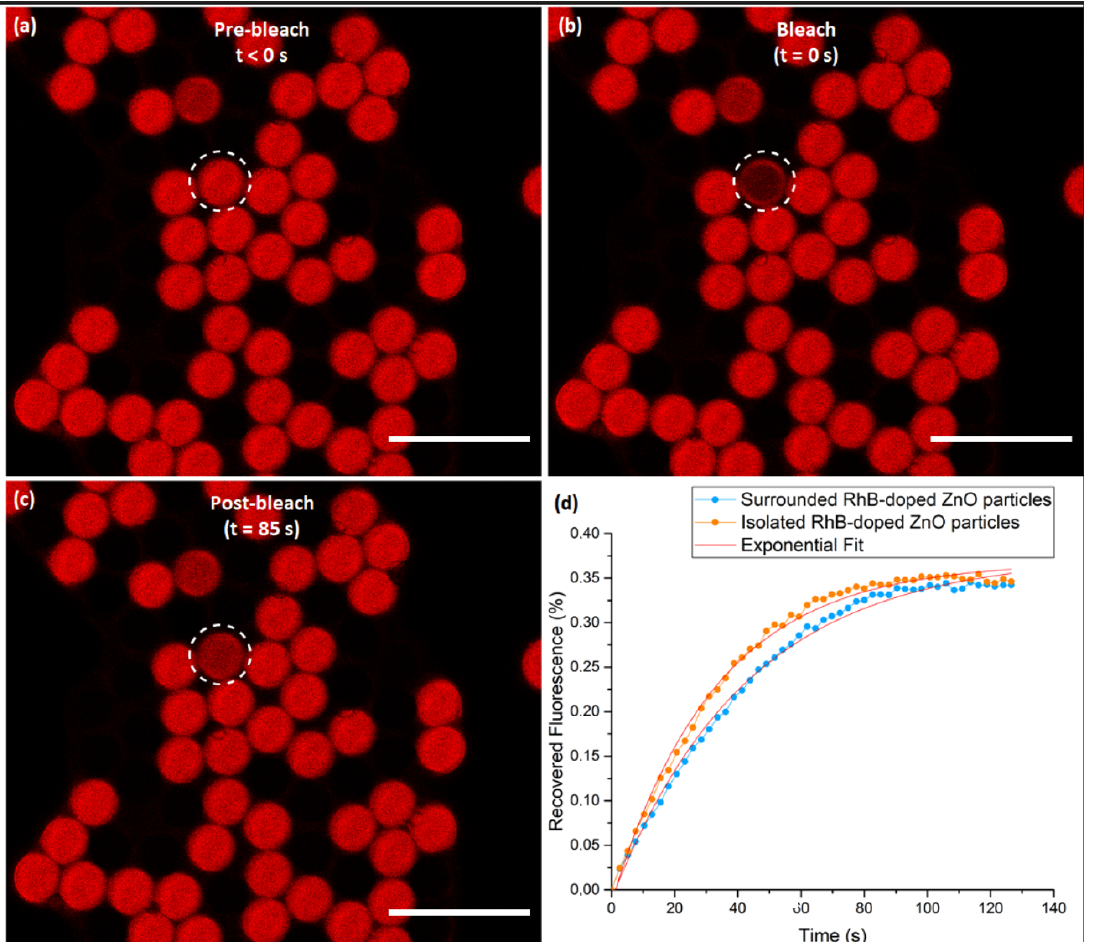
Figure 9. Confocal microscopy images recorded during a FRAP experiment on ZnO microspheres uniformly labeled with rhodamine B dye: ( a ) taken before photobleaching; ( b ) immediately after photobleaching the spherical inner part of the microsphere, with short pulse of intense laser light, showing that the selective ROI is no longer fluorescent; ( c ) recorded during the recovery after photobleaching; and ( d ) the recovery curve that demonstrates an increase in fluorescence intensity as the bleached dye diffuses and the new unbleached dye move into the ROI. The white dashed circles represent the selected microsphere for photobleaching. Scale bars: 50 µ